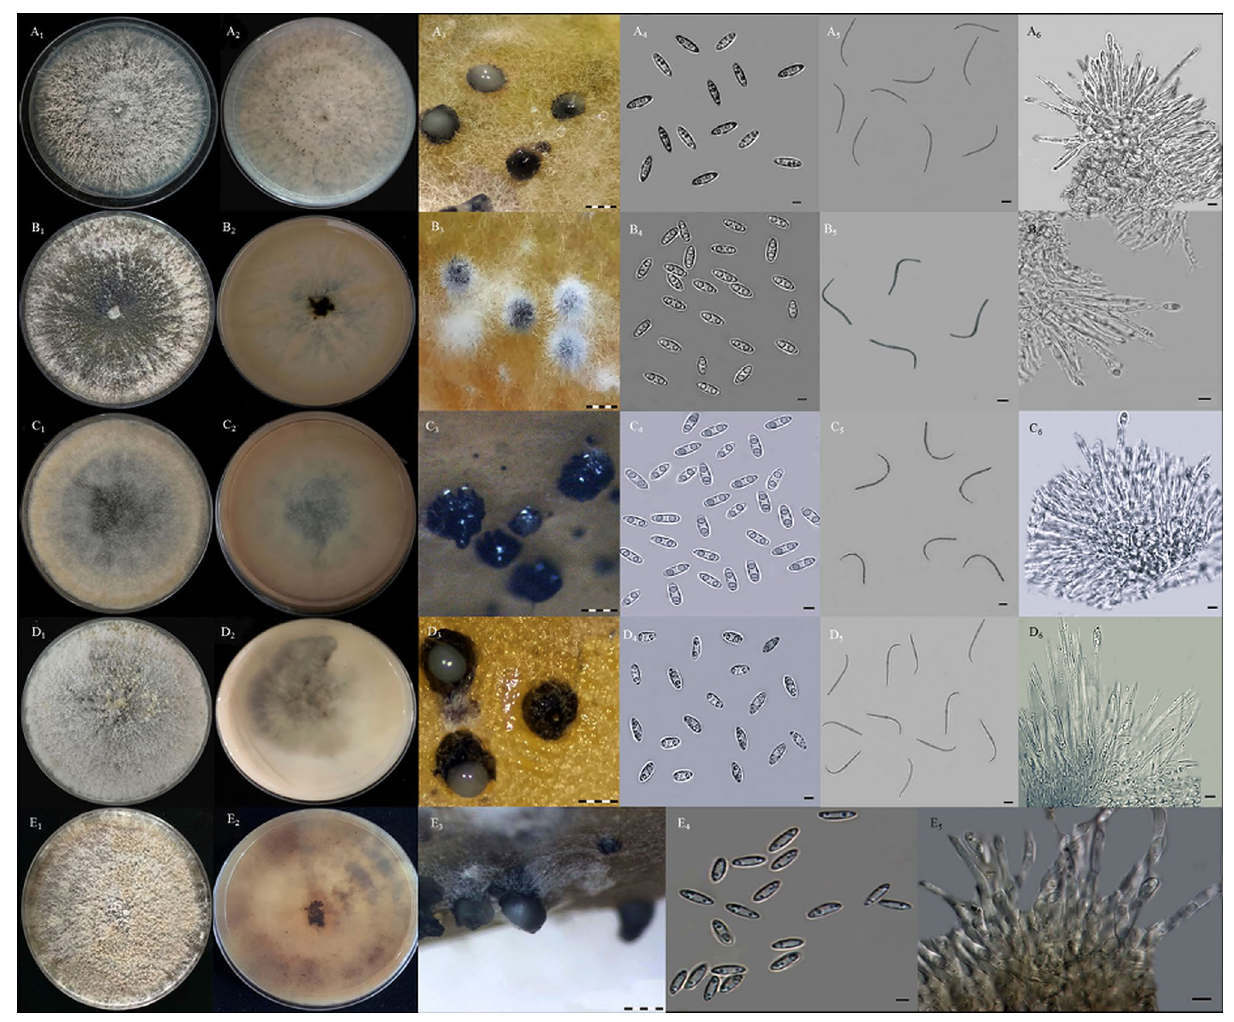
Figure 1. Morphological characteristics of Diaporthe species isolated from stem gray blight of H. polyrhizus . Group 1 (